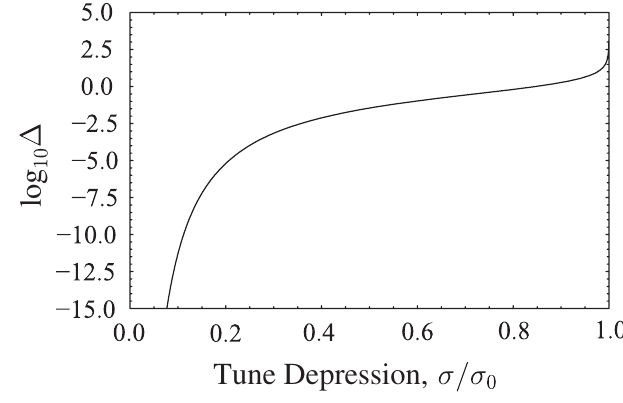
FIG. 18. Thermal equilibrium parameter (cid:1) plotted versus rms- equivalent beam tune depression (cid:3)=(cid:3) Eq.